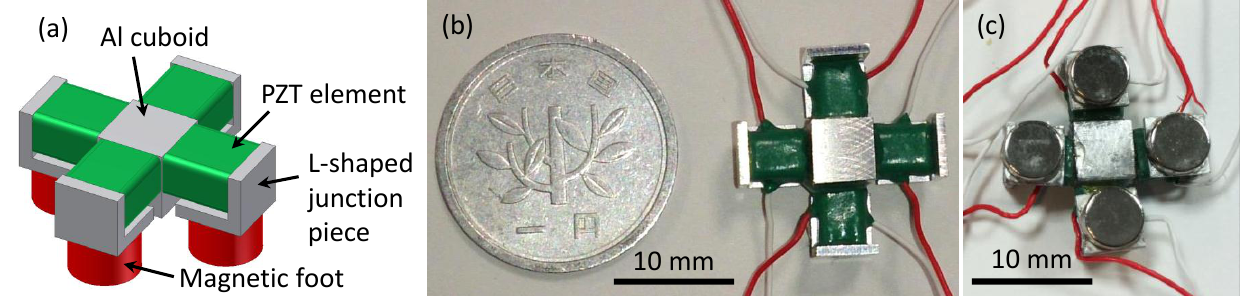
Figure 1. ( a ) Schematic diagram of the designed positioner. ( b ) Top view of the prototype of the designed positioner compared with a coin. ( c ) Bottom view of the prototype of the designed